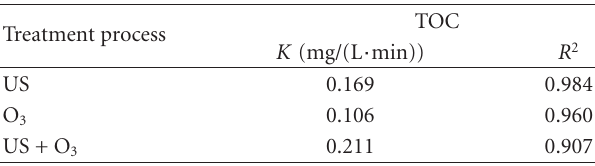
Table 3: DCF degradation rate constants ( K ) in terms of TOC referred to sonolysis (20kHz, 400 W/L, NTC), ozonation (31g/h), and their combination (US + O 3 ) for an initial DCF concentration of